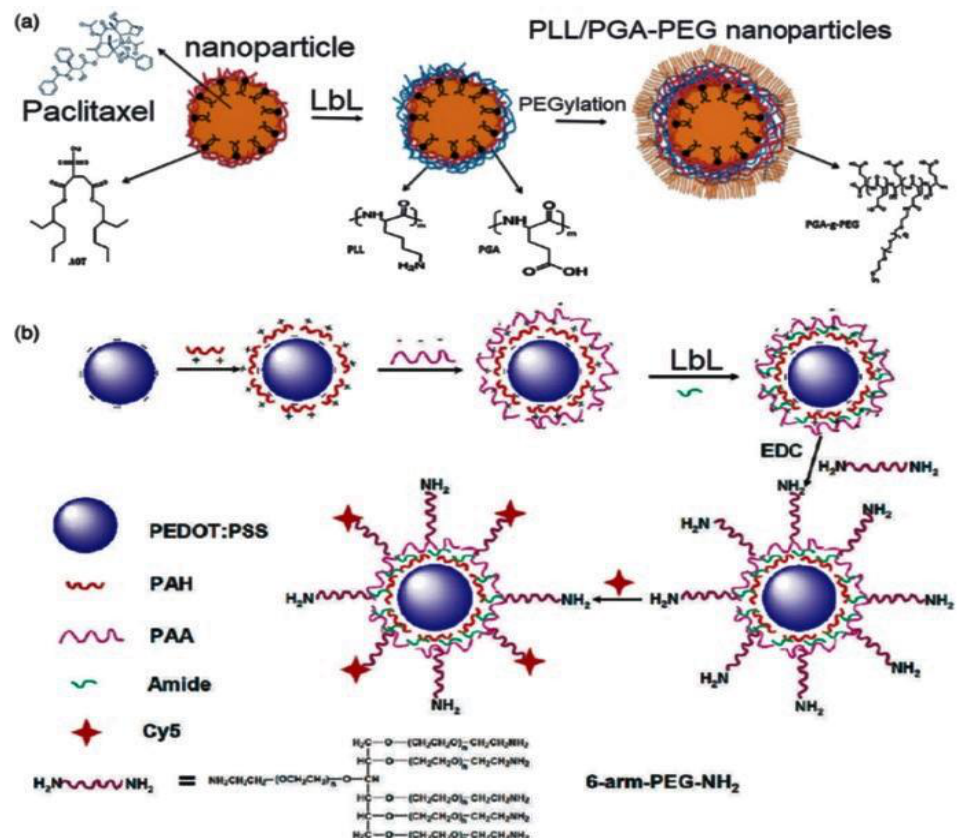
Figure 5. ( a ) Representation of the LbL assembly of PEGylated PLL/PGA nanoparticles for controlled delivery of paclitaxel. Reprinted from [36], with permission from Elsevier. ( b ) LbL assembly of the PEDOT/PSS-PEG nanoparticles for targeted delivery of antitumor drugs. Reprinted from [37], with permission from the American Chemical Society.